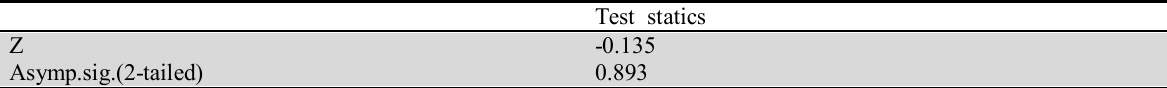
Wilcoxon signed rank test for paired comparisons Z